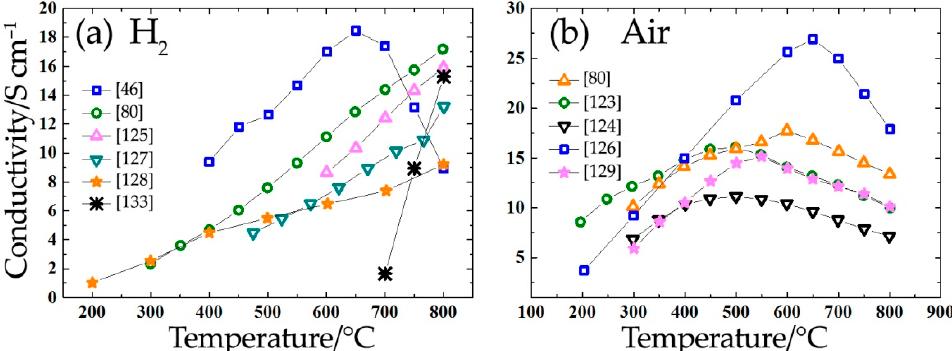
Figure 13. Conductivity values of the Sr 2 Fe 1.5 Mo 0.5 O 6– δ ceramic in reducing ( a ) and oxidizing ( b ) atmospheres. Table 6. Conductivity of Sr 2 Fe 1.5 Mo 0.5 O 6– δ . These data are also presented in Figure A2.